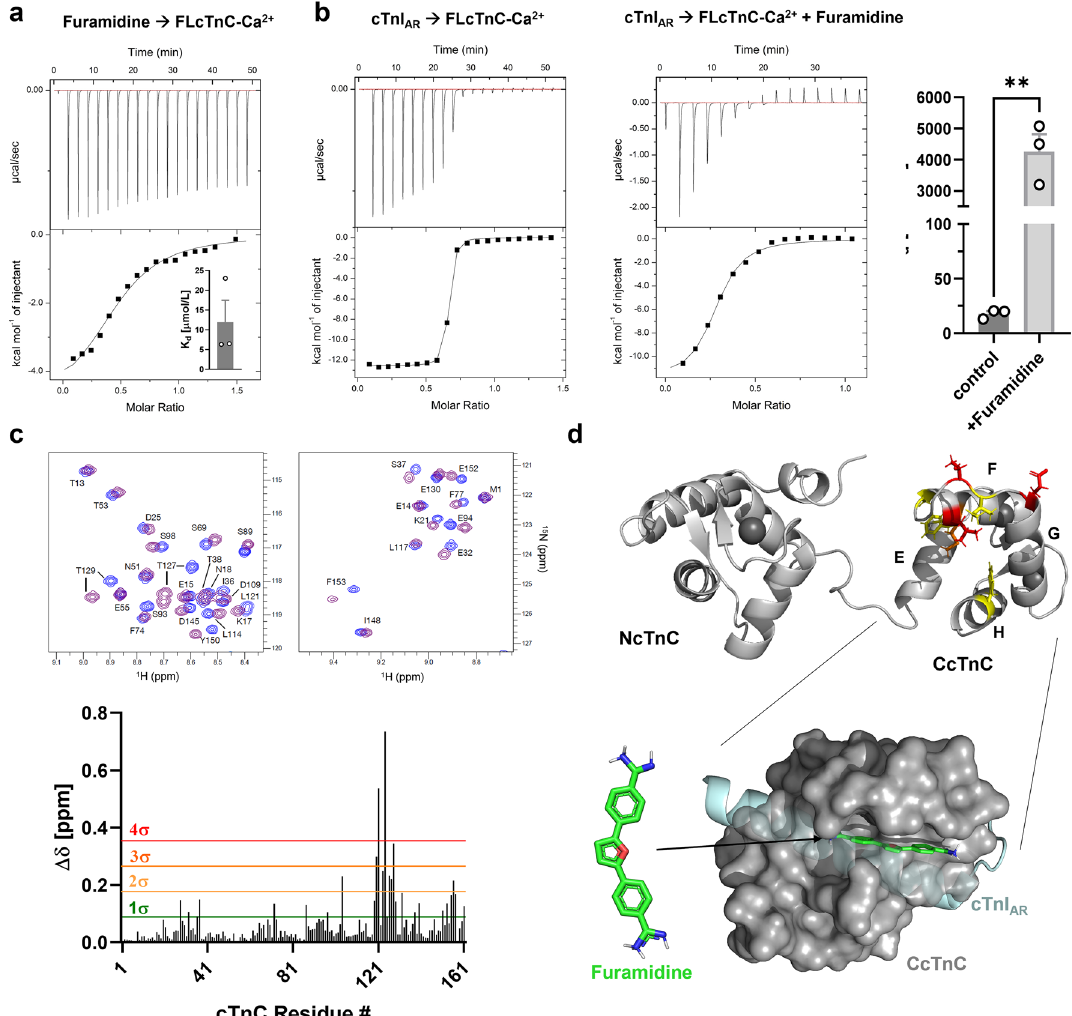
Figure 4. Biophysical characterization of Furamidine-cTnC interaction. ( a ) ITC for titration of Furamidine into cTnC. Insert: Measured steady-state dissociation constants. ( b ) ITC titration of unmodified cTnI AR into cTnC in the absence (left) and in the presence of Furamidine (middle). Measured steady-state dissociation constants are shown on the right. ( c ) Top: Part of 2D- 1 H- 15 N HSQC spectrum of cTnC in the absence (blue) and in the presence (purple) of Furamidine. Bottom: Plot of chemical shift perturbations (∆δ) of cTnC after addition of excess Furamidine. ( d ) Top: Chemical shift perturbations mapped onto cTnC structure with the same colour coding as shown in ( c ). Bottom: Docking pose for Furamidine (green) binding to CcTnC (grey, surface representation) using flexible docking in AutoDock Vina. The position of cTnI AR (cyan) in the cardiac troponin complex (PDB 1J1D) was superimposed onto the structure. Means ± SEM, n=3. Statistical significance between control and drug treatment was assessed with an unpaired two-tailed student’s t-test: